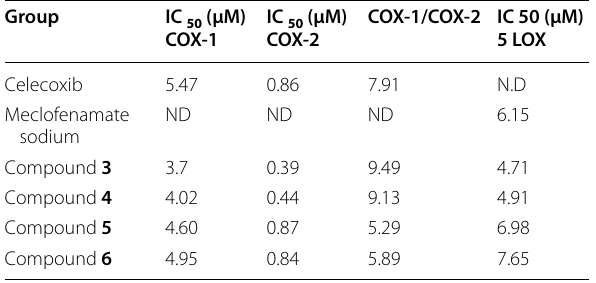
Table 2 Inhibition percent of rat paw edema after administration of newly synthesized compounds